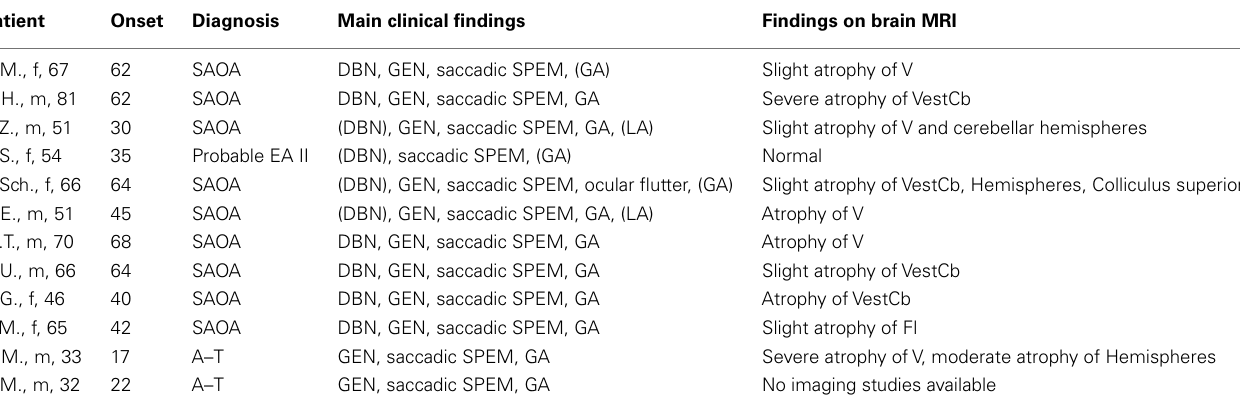
Table 1 | Demographic and clinical data of all patients with diffuse, chronic vestibulo-cerebellar